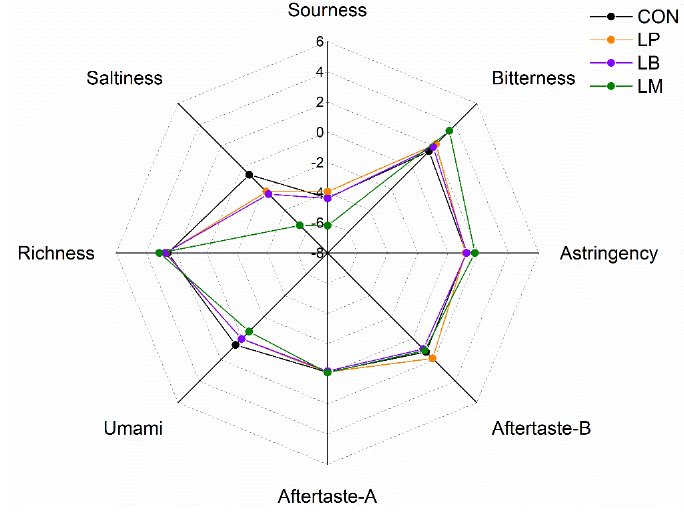
Figure 5. The E-tongue profiles of Suancai fermented with different autochthonous